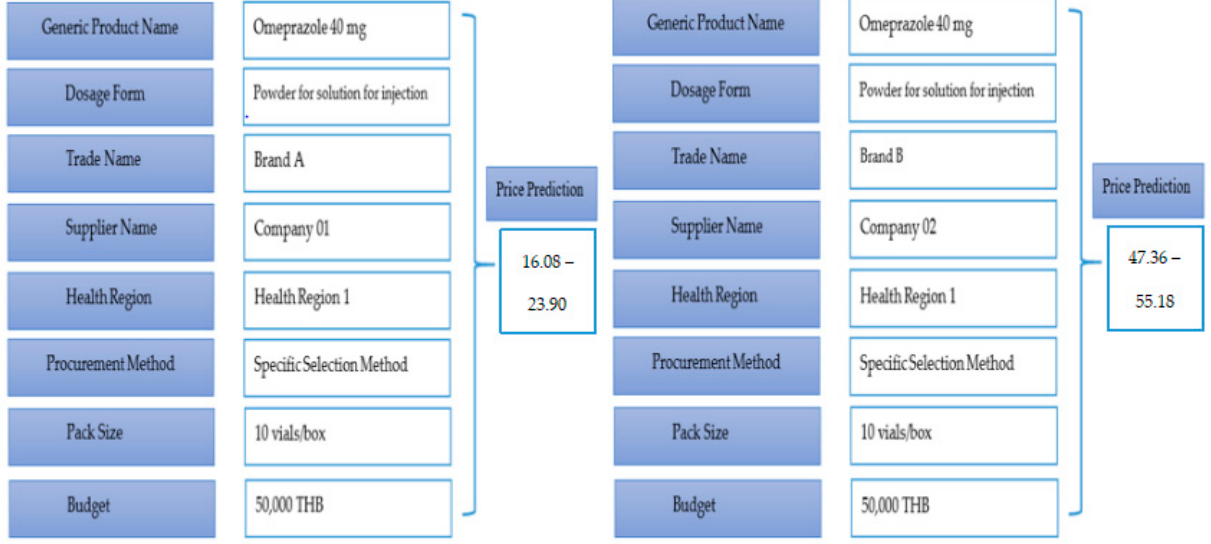
Figure 5. Examples of price prediction by using the model derived by the SMO algorithm with selection technique of the gain-ratio feature.